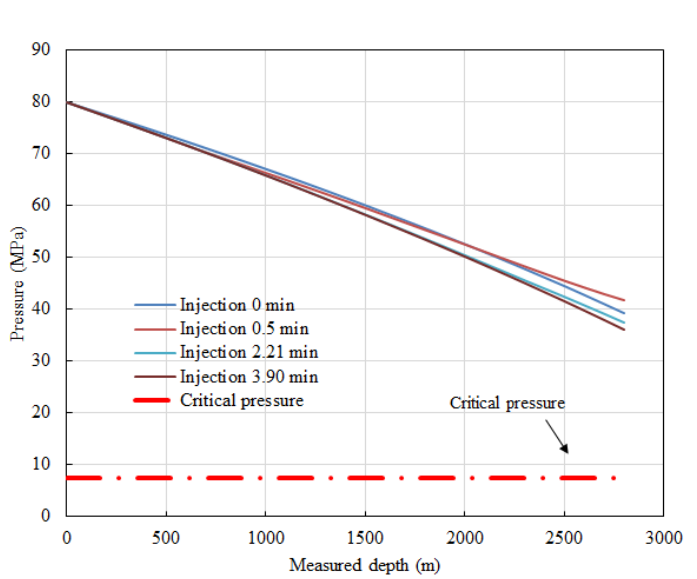
Figure 4. Pressure profiles at different injection times.